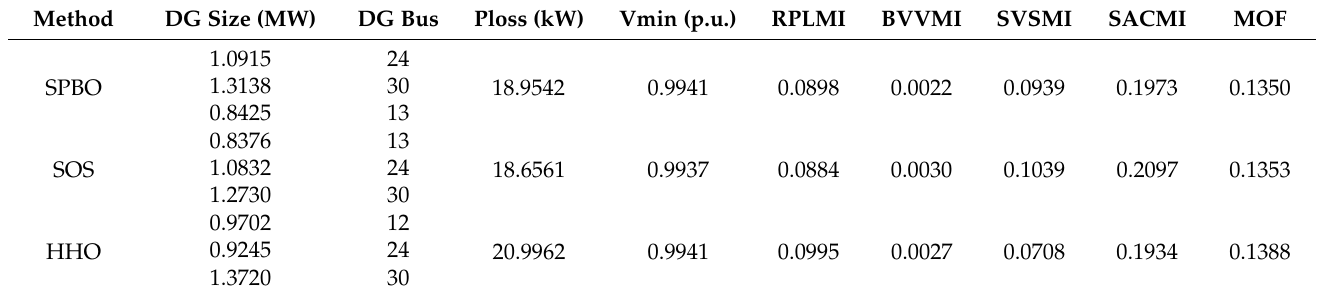
Table 7. Comparison of results for exclusive GT-DG allocation (case-4) for 33-bus test system.